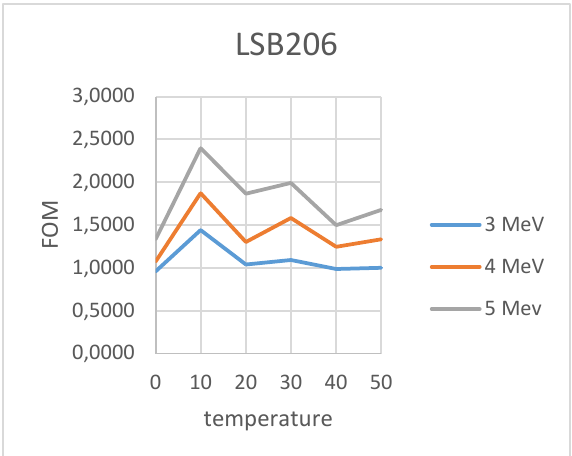
Fig. 2. FOM temperature dependencies of the